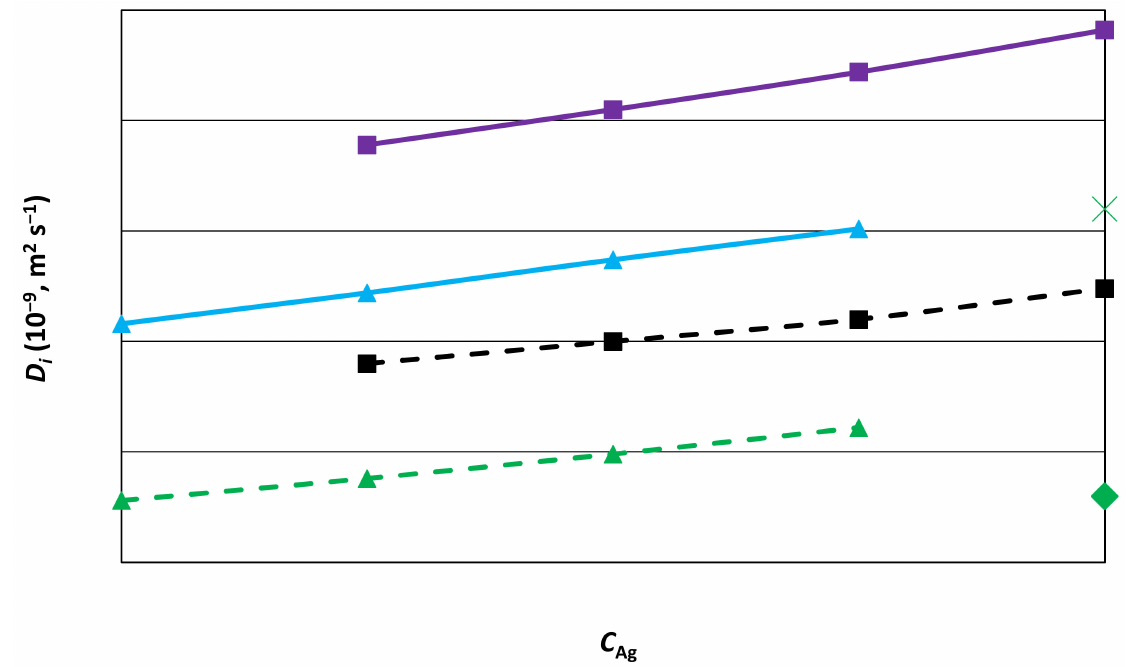
Figure 3. Self-diffusion coefficients of Ag (squares) and Au (triangles) in liquid Ag-Au alloy at T = 1423 K (dashed line) and T = 1573 K (solid line) in comparison with the self-diffusion coefficients of Au in pure Ag at T = 1300 K (rhombus) and at T = 1500 K (asterisk) taken from the experiment